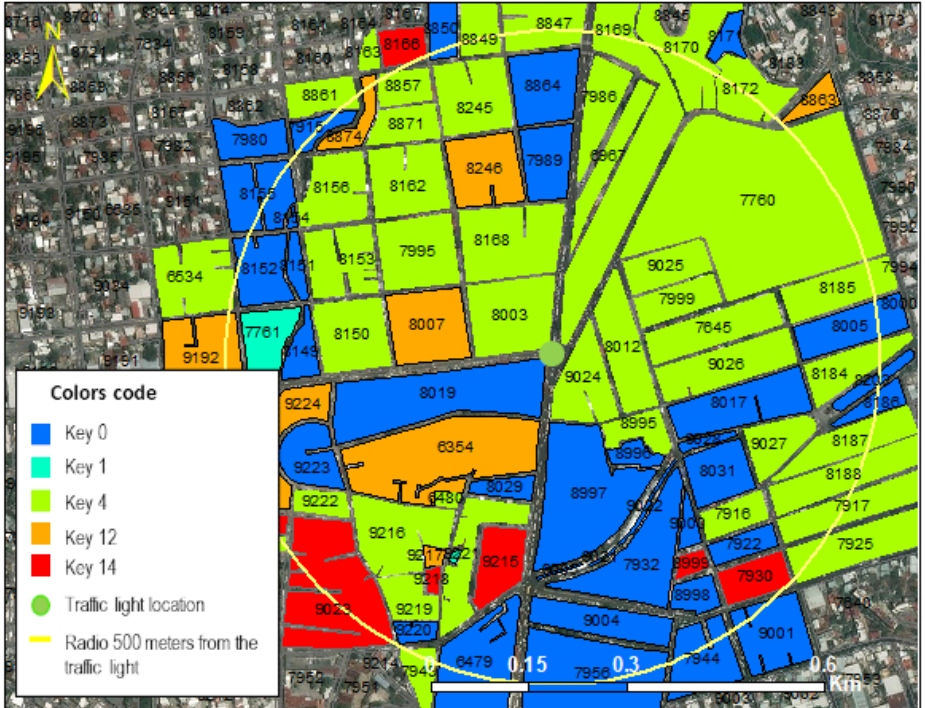
Figure 3. Tra ffi c light “Ejido and Constituyentes” with the selected Figure 3. Traffic light “Ejido and Constituyentes” with the selected blocks. Figure 3. Traffic light “Ejido and Constituyentes” with the selected blocks.